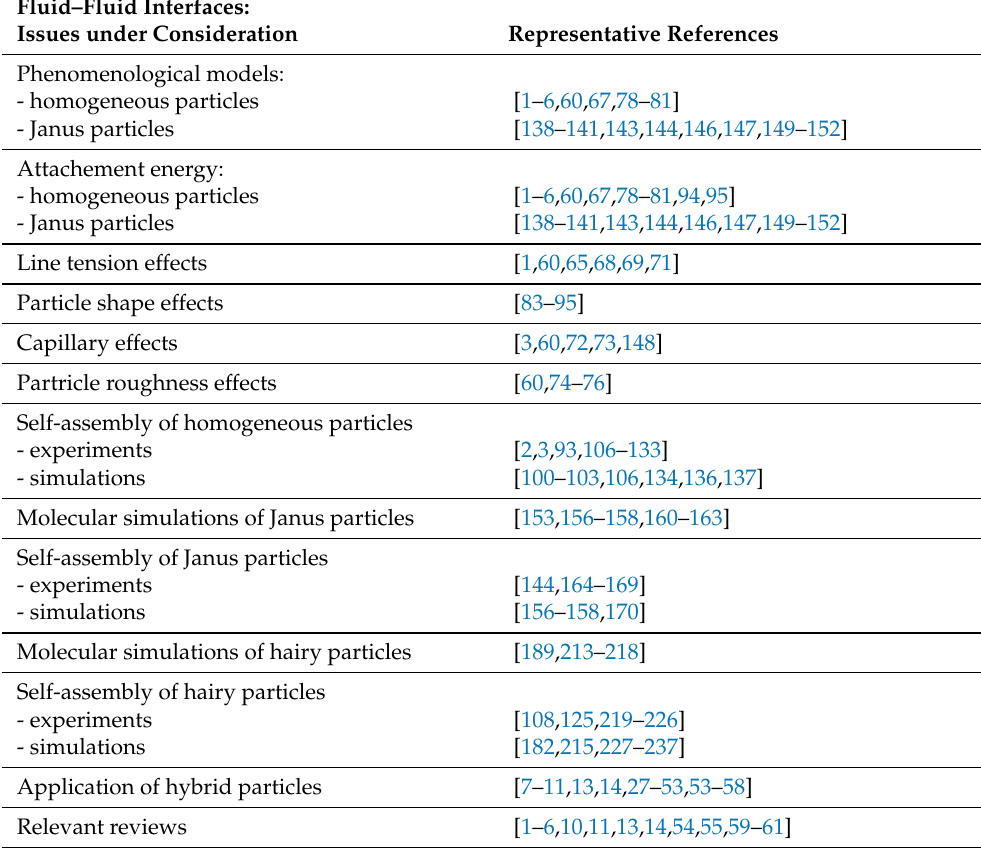
Table 1. The discussed issues with the relevant